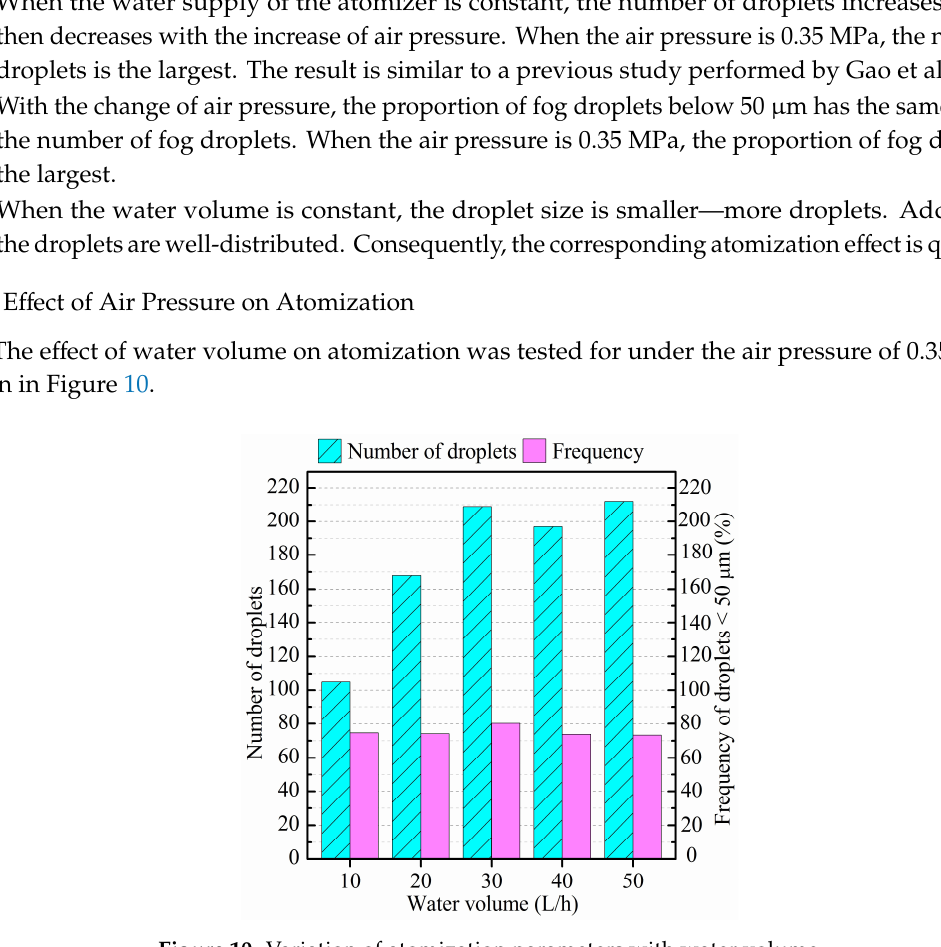
Figure 10. Variation of atomization parameters with water volume.